Question: What style of plot is this figure drawn as?
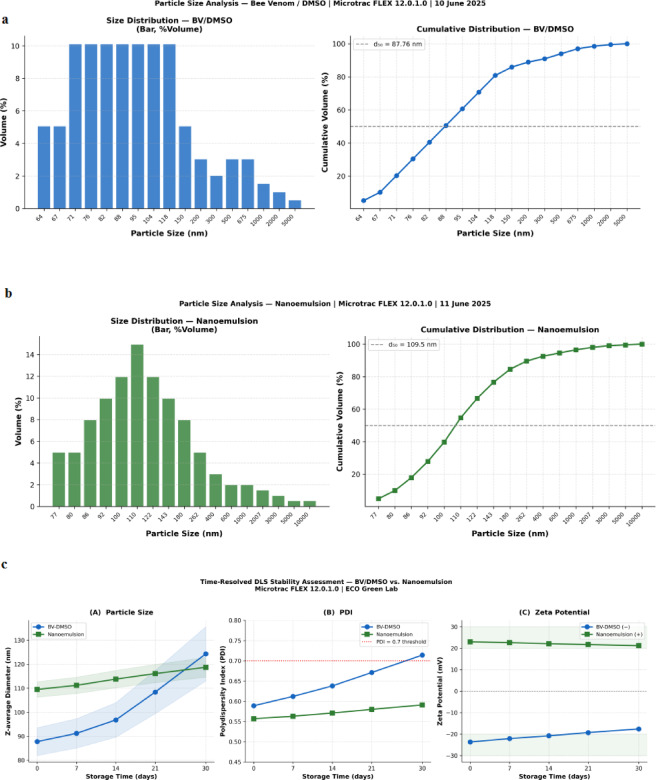
Answer: scatter